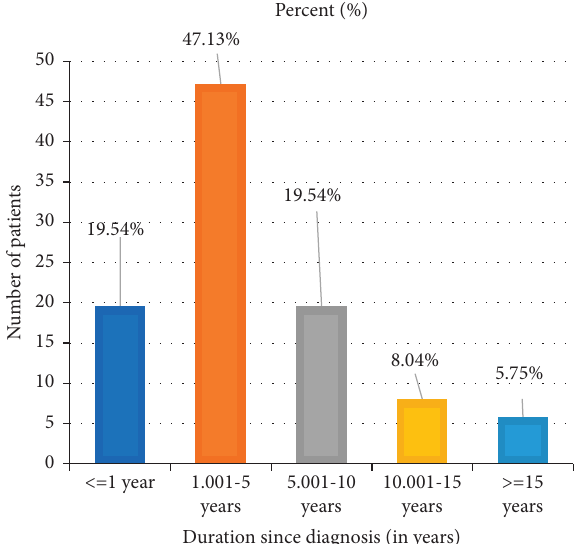
Figure 3: Duration of known diabetes among patients with DM admitted to JMC from October 01, 2020, to June 30,